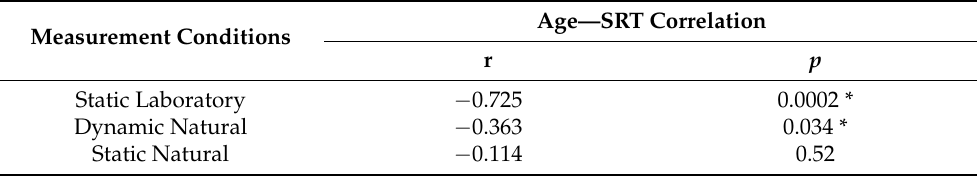
Table 2. The correlation coefficient of age and simple reaction time under selected measurement